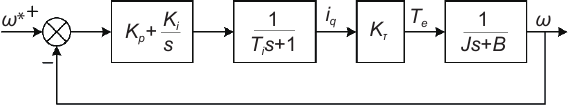
Fig. 7 Simplified equivalent speed-loop block